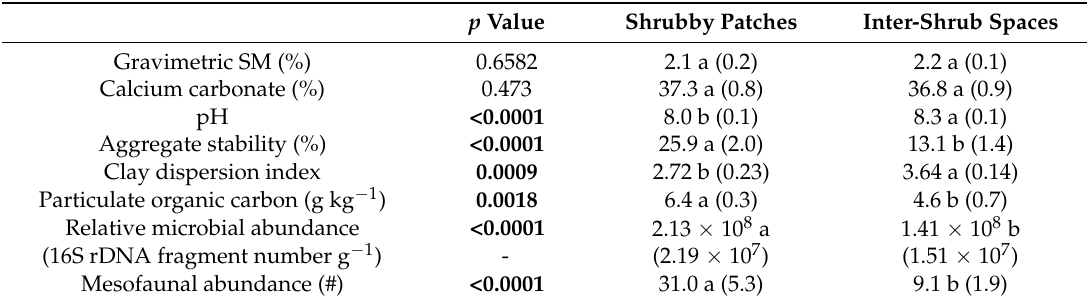
Table 3. Micro-habitat effect on soil characteristics. p Value Shrubby Patches Inter-Shrub